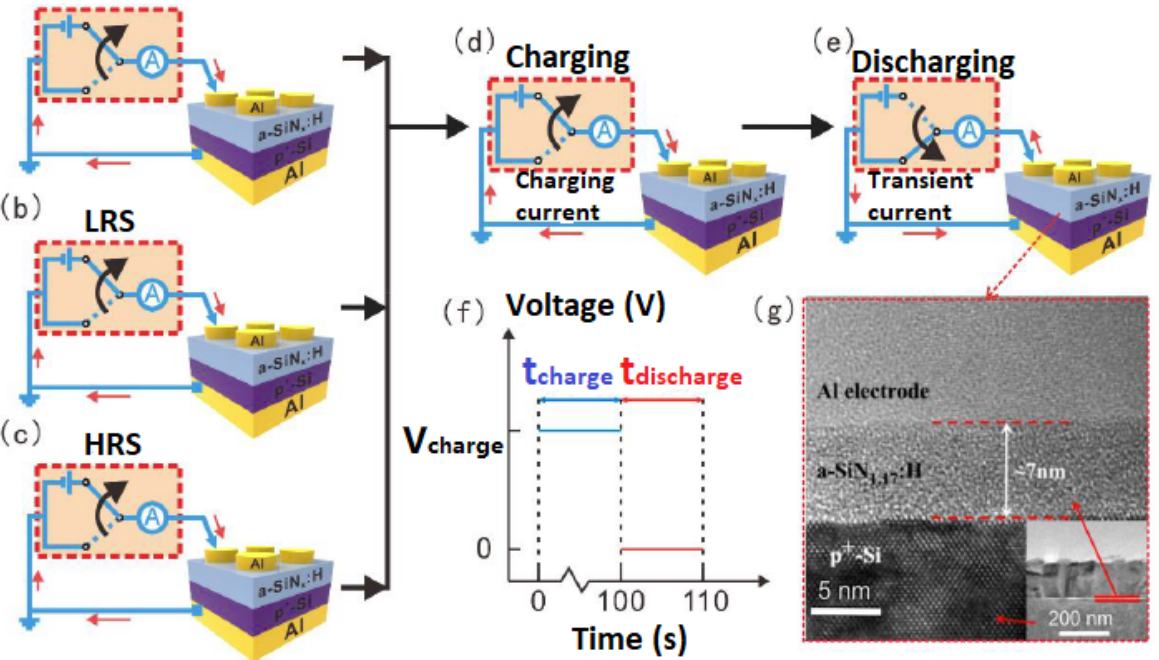
Figure 1. ( a – e ) Schematic illustration of the transient current measurement of an Al/a-SiN x :H/P+-Si at different resistive switching states. ( f ) Oscillogram of the applied pulse for the transient current measurement. ( g ) Cross-sectional HRTEM photo of the Al/a-SiN 1.17 :H/p+-Si. The inset shows the low-resolution TEM photo.